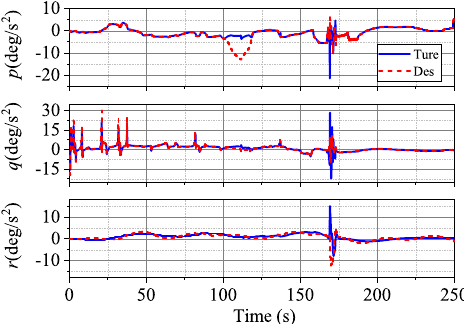
Figure 20. Results for p , q , and r without SE.